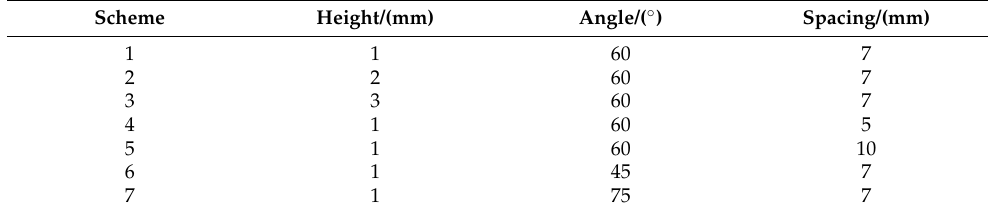
Table 2. Parameters of seven types of shear